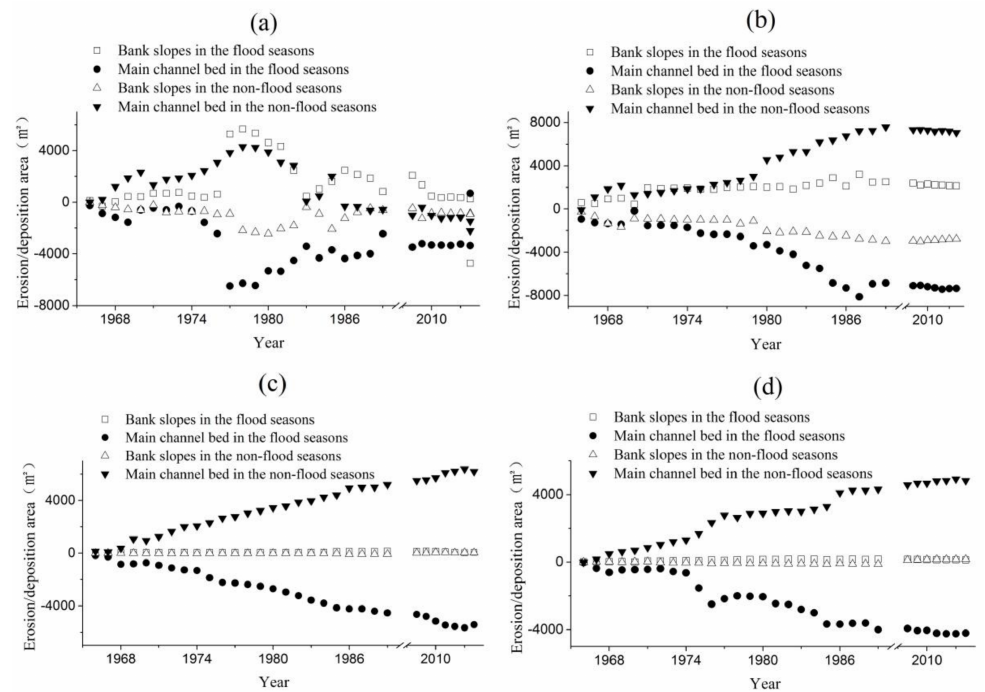
Figure 7. Cumulative seasonal erosion and siltation of bank slopes and main channel bed in